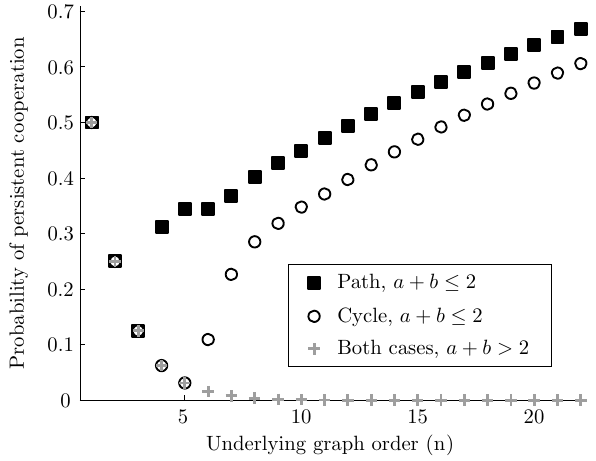
Figure 7: The probability that a randomly generated initial state of the ESPD on a path or cycle of order 1 n 22 leads to persistent cooperation. ≤ ≤